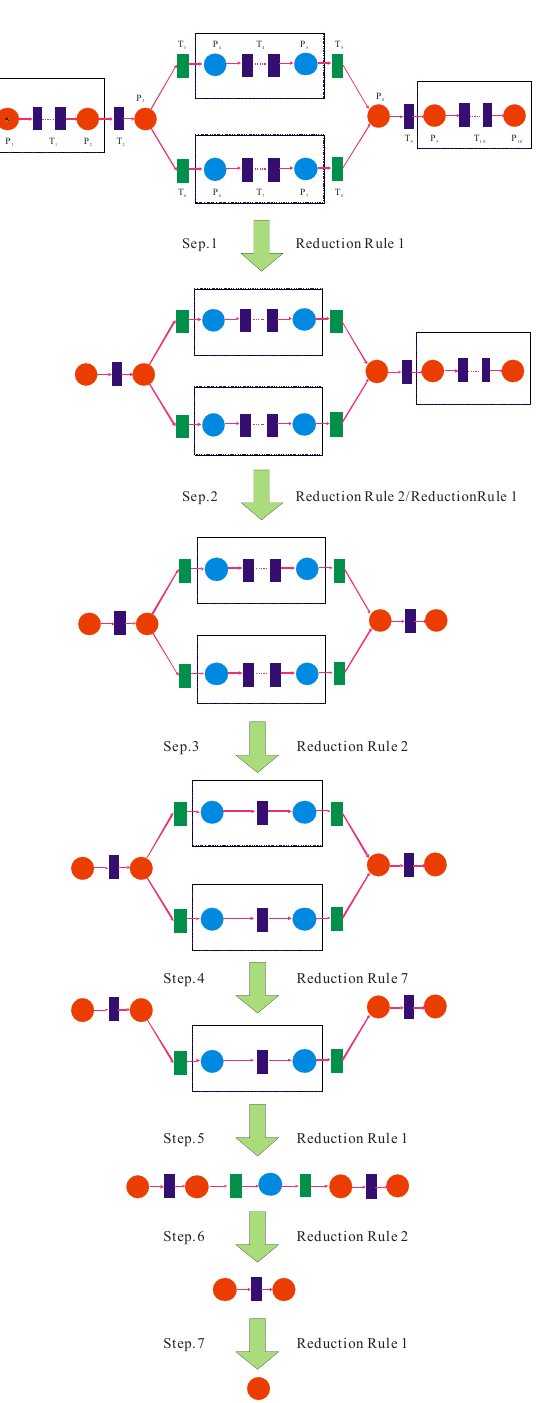
Fig.24. Verification for conferencing informing service